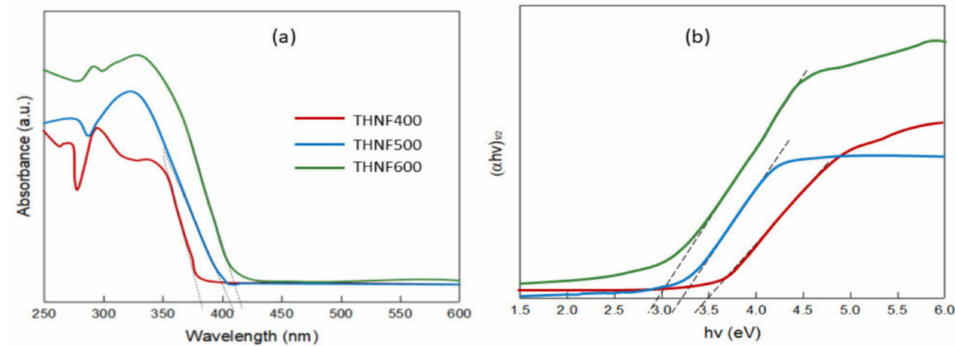
Figure 6. ( a ) UV–Vis diffuse reflectance spectra; ( b ) Tauc plot for bandgap